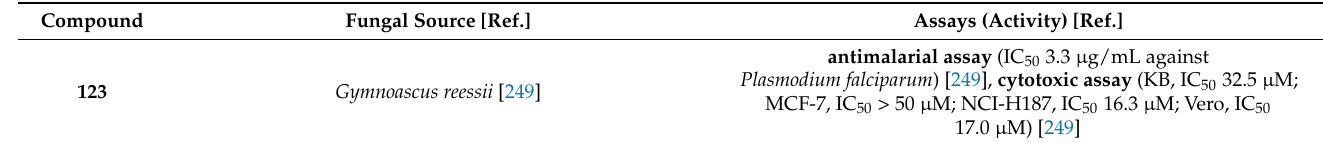
Figure 14. Structures of fungal ketones. Table 5. Sources and biological activity of fungal